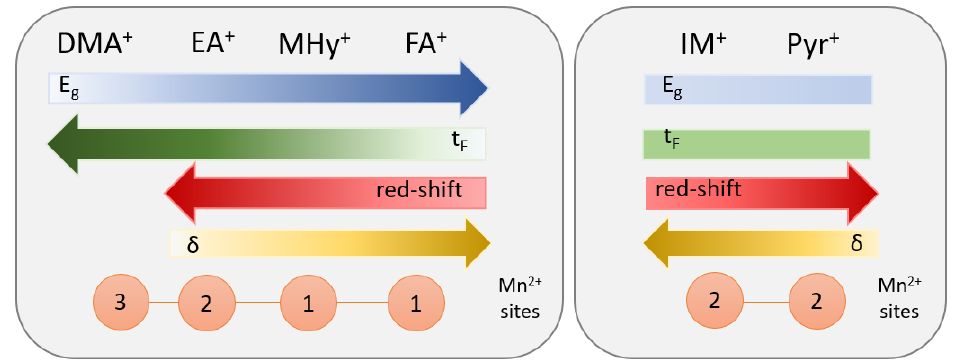
Figure 8. Influence of the amine applied in [A]Mn(H 2 POO) 3 compounds on structural and optical features. The scheme shows the correlation between the structural parameters (such as t F , octahedral deviation ( δ ) from the perfect cubic shape, and the number of Mn 2+ sites) and the optical properties (energy band gap and PL position).